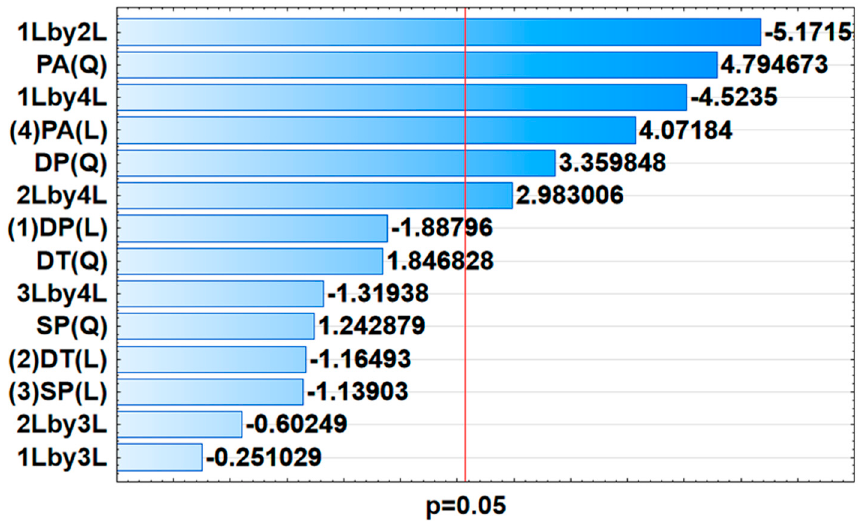
Figure 7. Pareto charts showing the significance of independent factors and their interactions for the determination of Zn(II).